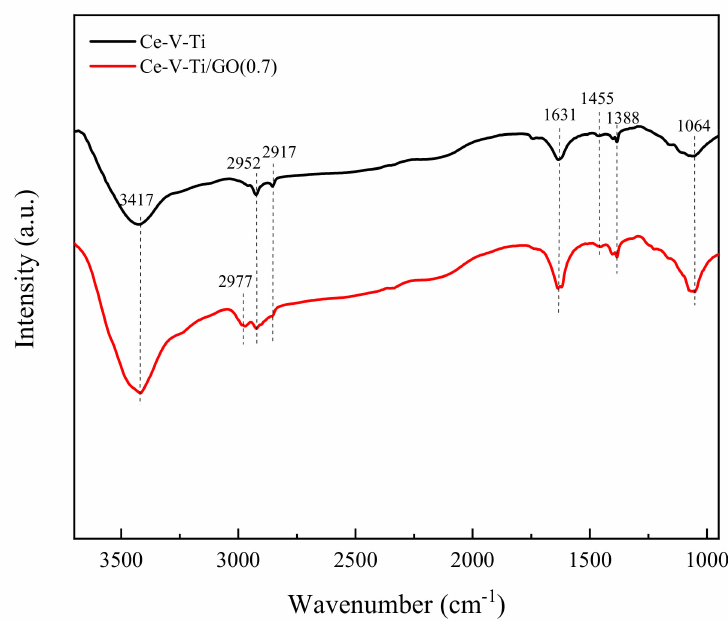
Figure 9. Fourier transform infrared (FTIR) spectra of the Ce-V-Ti and Ce-V-Ti / GO